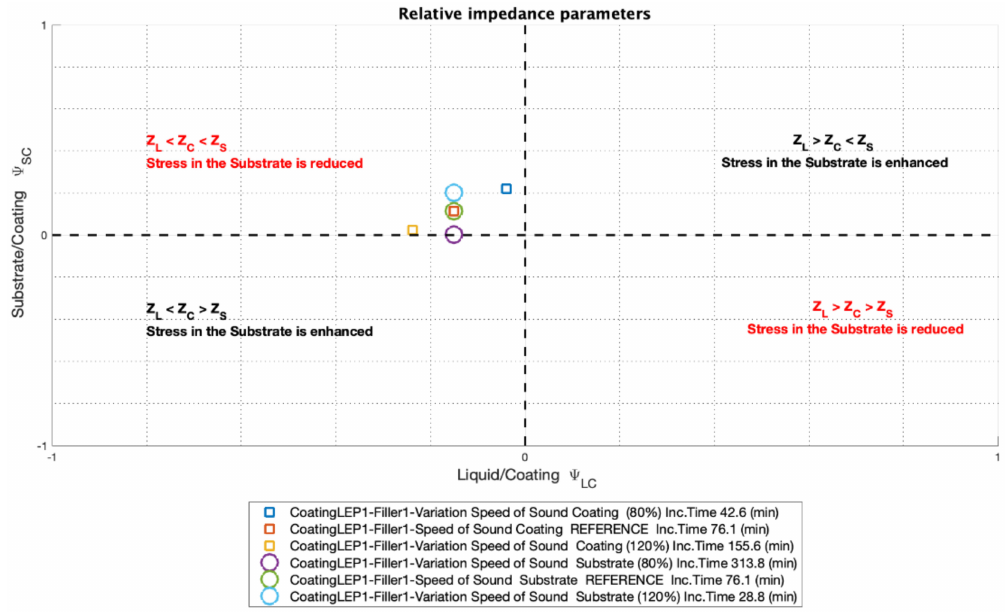
Figure 9. Relative impedance values comparing lifetime prediction due to 20% variation (computing 80% and 120% values) of the Coating c c and Substrate c s Speed of